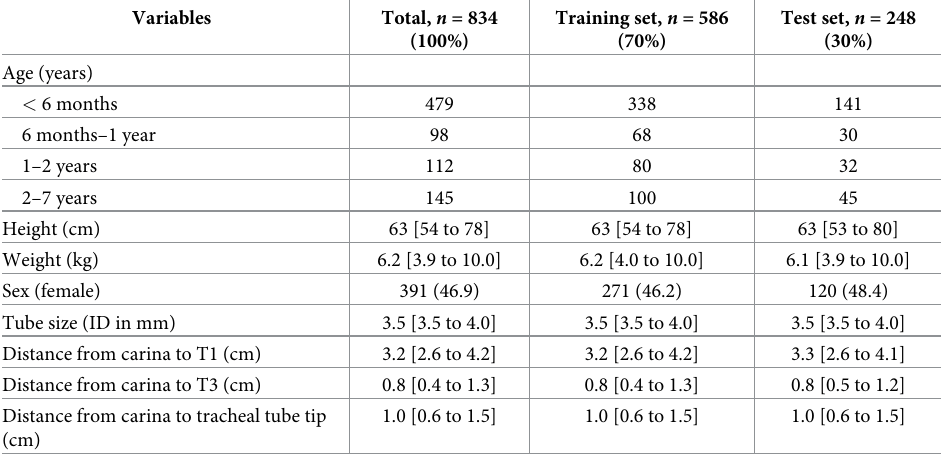
Table 1. Patient demographic data and variable